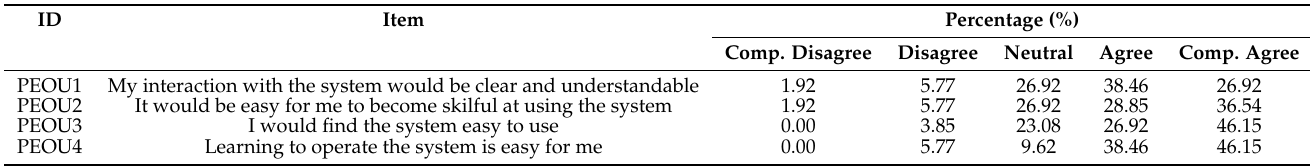
Figure 5. Survey results for ‘Perceived Ease of Use’. Table 3. Numerical results for ‘Perceived Ease of Use’.